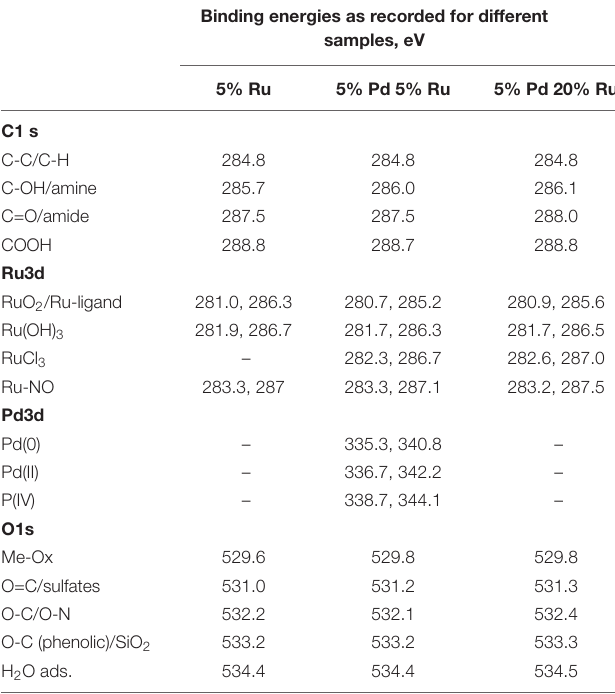
TABLE 4 | XPS peak positions for the various components identified in the high resolution elemental spectra. Binding energies as recorded for different samples,